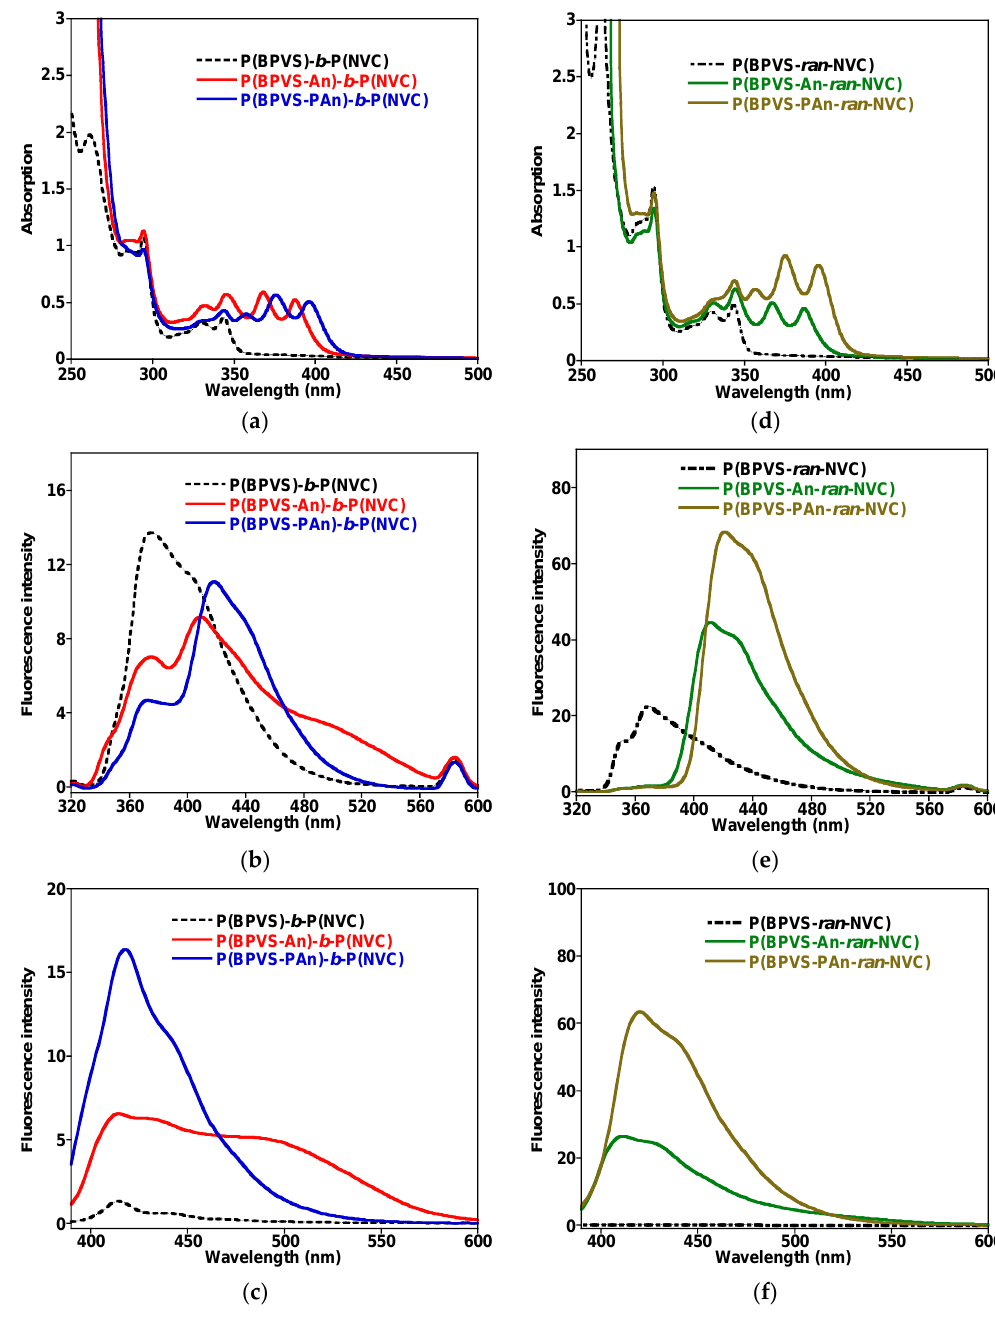
Figure 1. UV-vis absorption spectra (conc. = 1.0 × 10 −4 carbazole unit mol/L in THF) of ( a ) block copolymers and ( d ) random copolymers, and fluorescence spectra (conc. 1.0 × 10 −5 carbazole unit mol/L in THF) of ( b , c ) block copolymers (excitation wavelength: ( b ) 294 and ( c ) 369 nm, respectively) and ( e , f ) random copolymers (excitation wavelength: ( e ) 294 and ( f ) 369 nm, respectively). For excitation at 369 nm, corresponding to the absorption wavelength of the anthracene unit, no significant energy transfer was observed from the anthracene unit to the carbazole unit in both block and random copolymers, resulting in a drastic decline in the intensities of the anthracene-based fluorescent peaks (Figure 1c,f). Besides, the incorporation of phenylanthracene (PAn) units in both